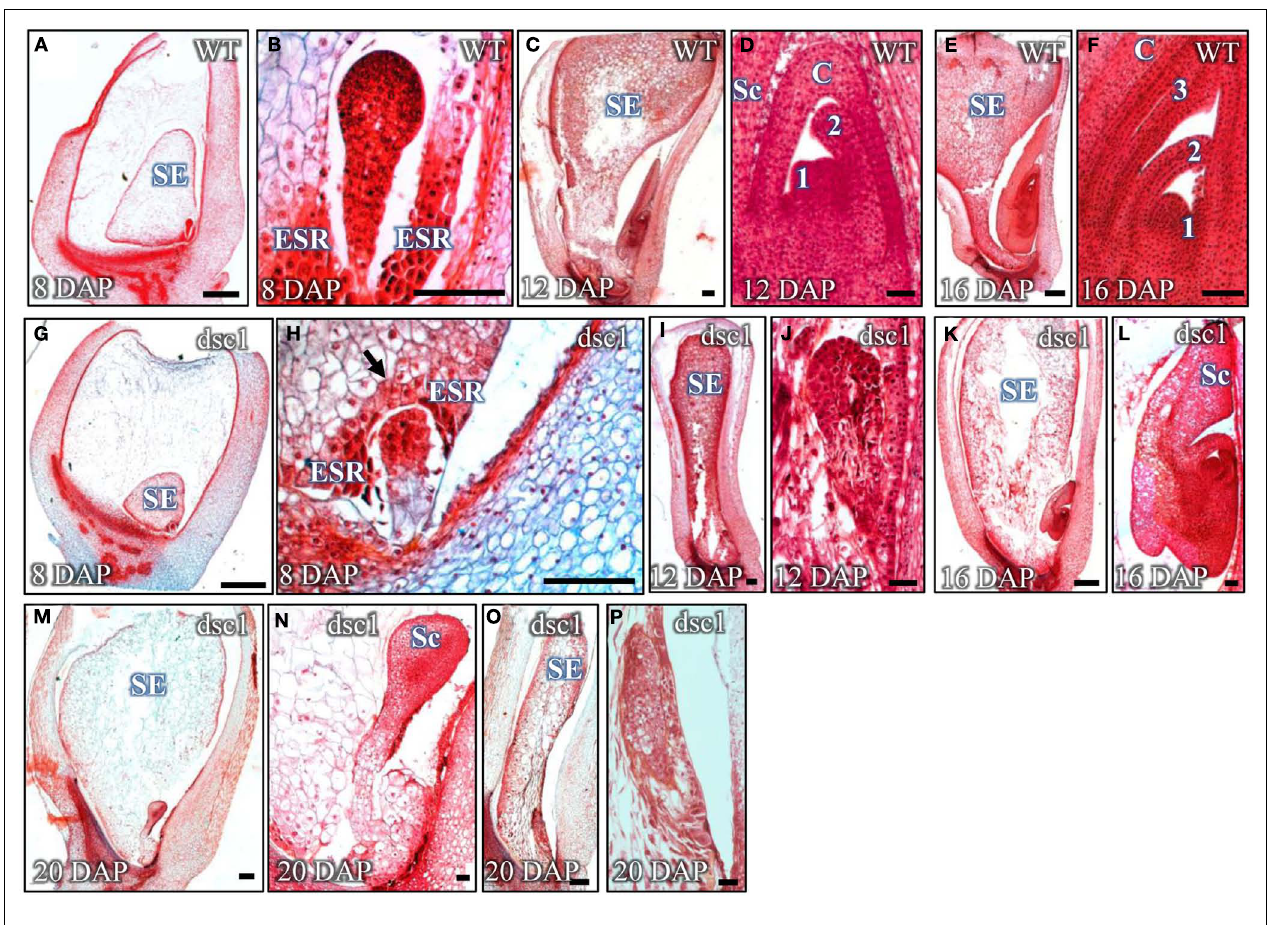
images in (A,C,E,G,I,K,M,O) , respectively. DAP, days after pollination; ESR, embryo surrounding region; SE, starchy endosperm; Sc, scutellum; C, coleoptile; 3, foliar leaf 3; 2, foliar leaf 2; 1, foliar leaf 1. Arrow points to intact ESR in dscl mutant kernel. Scale bars in (A,C,E,G,I,K,M,O) represent 500um and in (B,D,F,H,J,L,N,P) represent